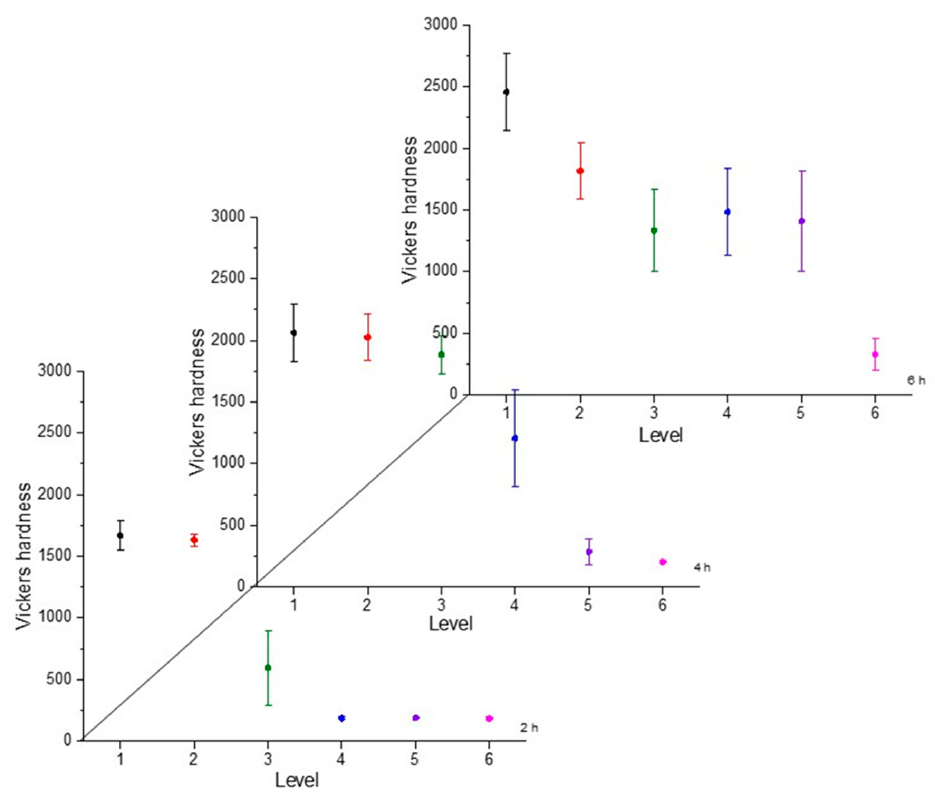
Figure 6. Microhardness evolution after boriding treatment at 950 °C.